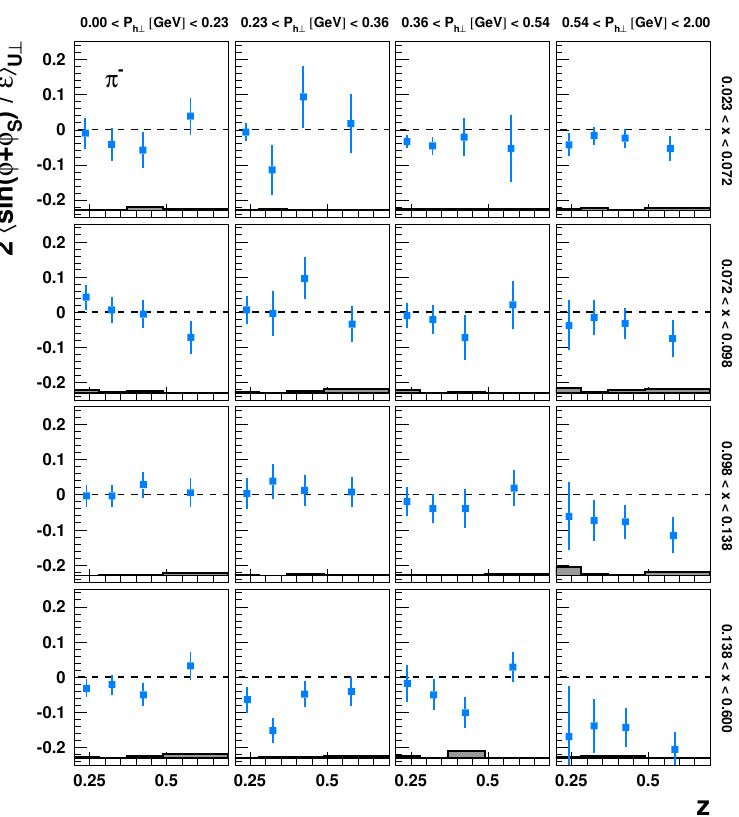
Figure 10 . Collins SFA for π − extracted simultaneously in bins of x , z , and P h ⊥ , presented as a function of z . Systematic uncertainties are given as bands, not including the additional scale uncertainty of 7.3% due to the precision of the target-polarization determination.